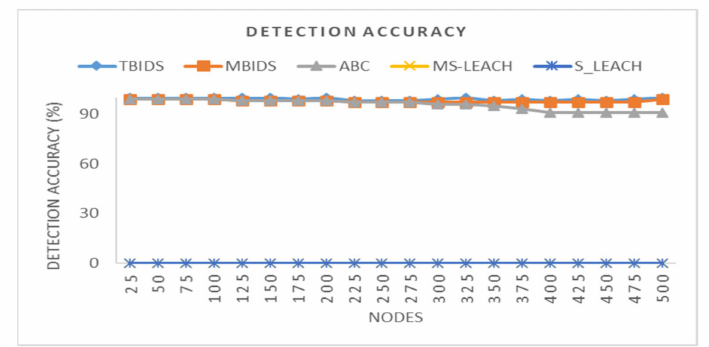
Figure 7. Single sink node and two sinkholes.